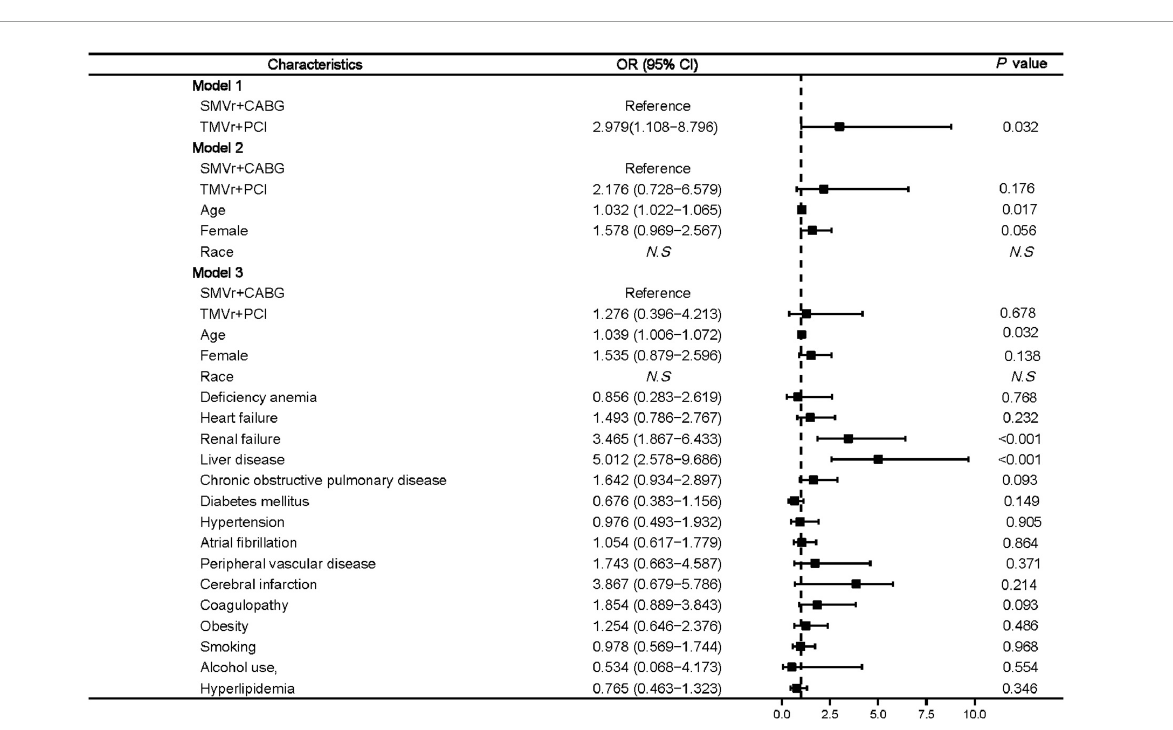
2.578–9.686]; P < 0.01) ( Figure 3 ) were associated with